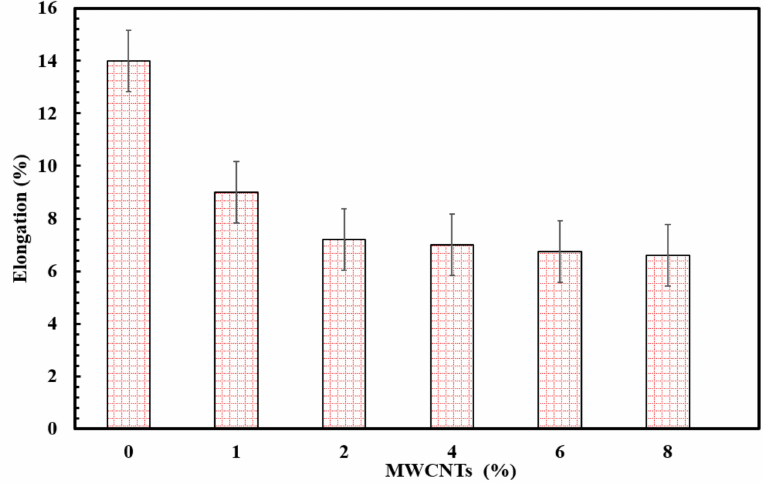
Figure 5. Effect of MWCNTs on elongation of PP-GF